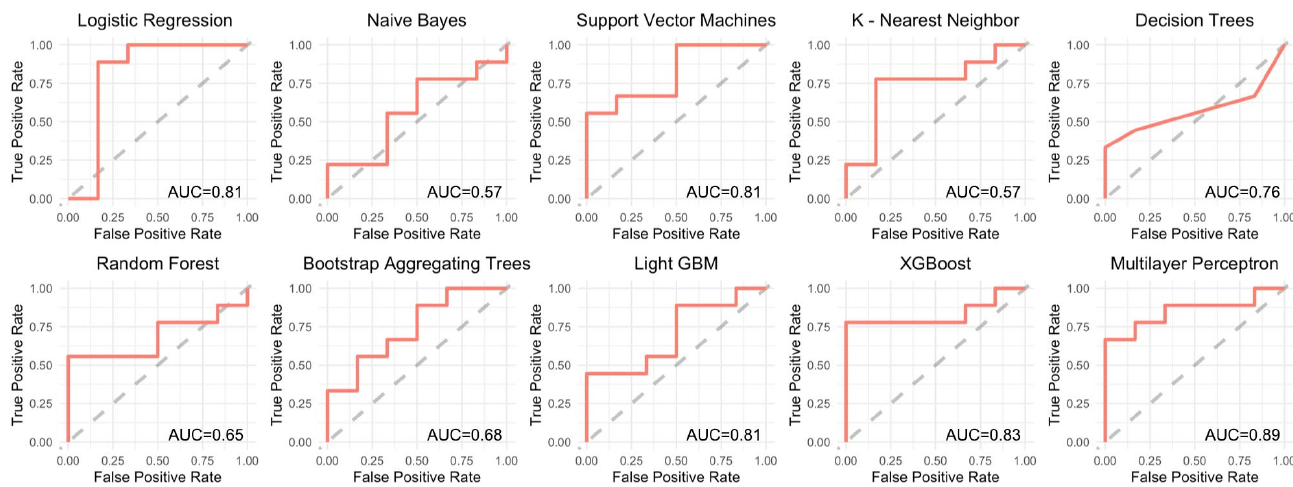
Figure 4. The AUC of single candidate gene/CpG site with respect to pregnancy prediction.